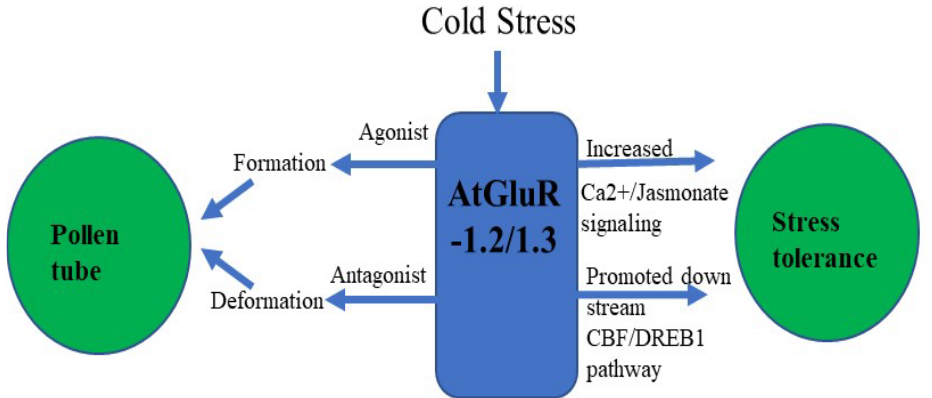
Figure 6. Flowchart of AtGluR-1.2/-1.3.